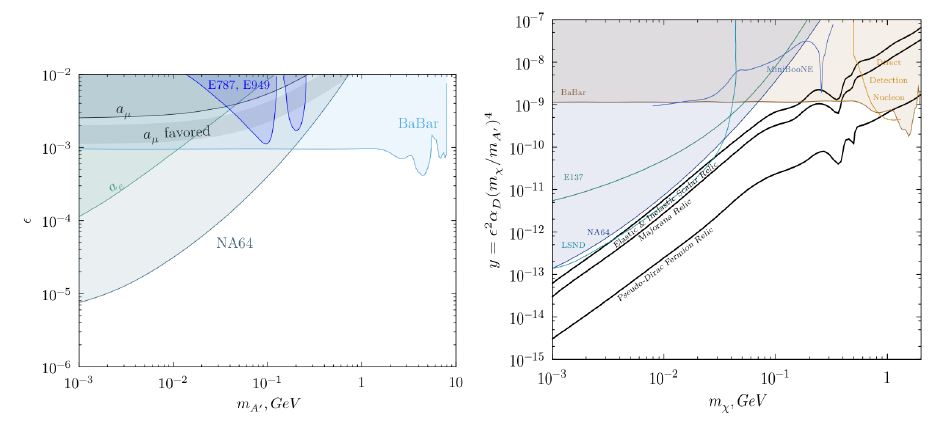
Figure 4. The sensitivity of NA64 to DarkPhotons with the full statistics collected in 2016 - 2018. Left plot: in terms of the mixing strength (cid:15) . Right plot: in terms of the variable y , assuming α D = 0 . 1 and m A (cid:48) = 3 m χ , shown together with the predictions of some popular thermal Dark Matter